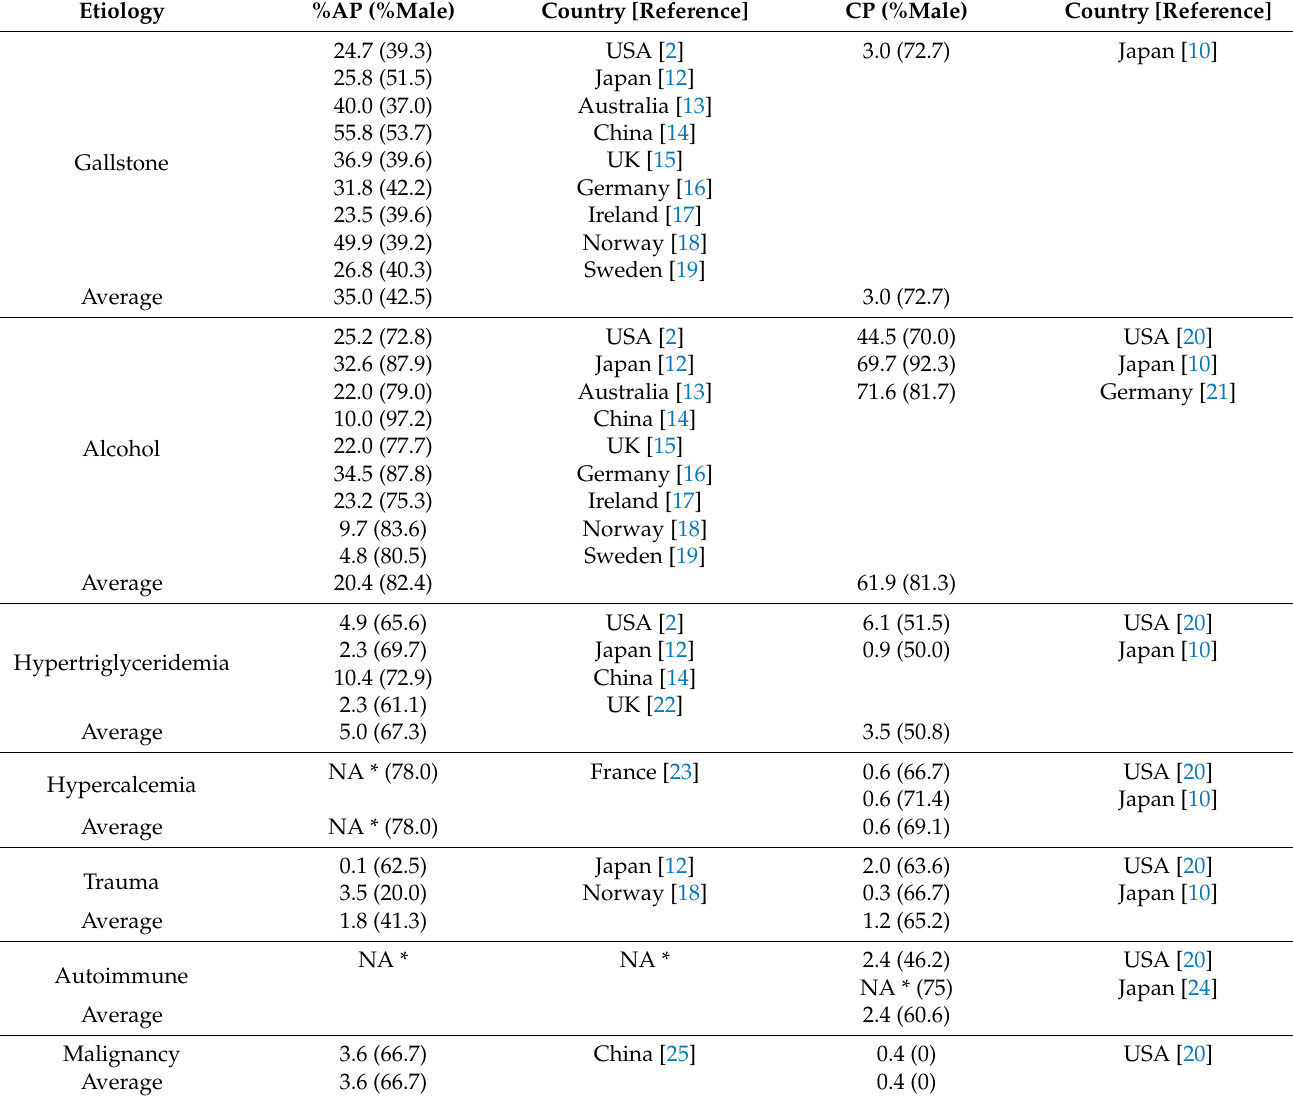
Table 1. Common Etiologies Respective to Acute or Chronic Pancreatitis (AP/CP) by